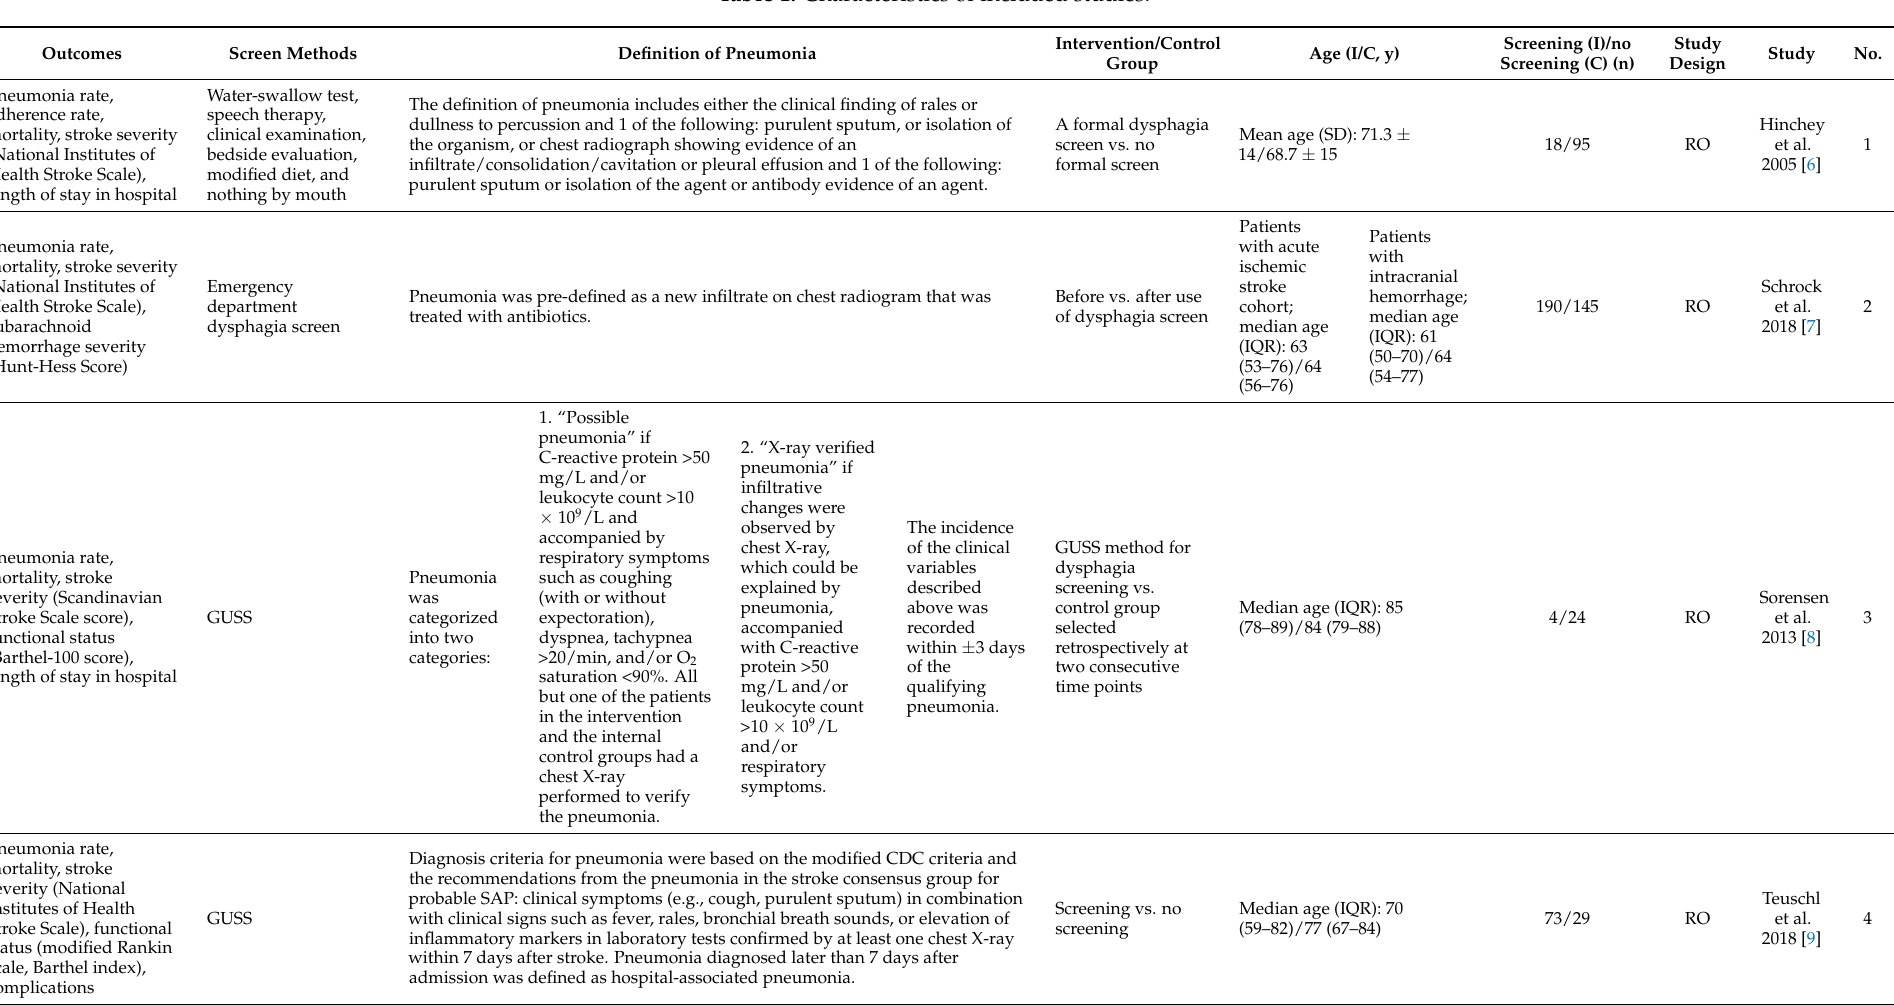
Table 1. Characteristics of included